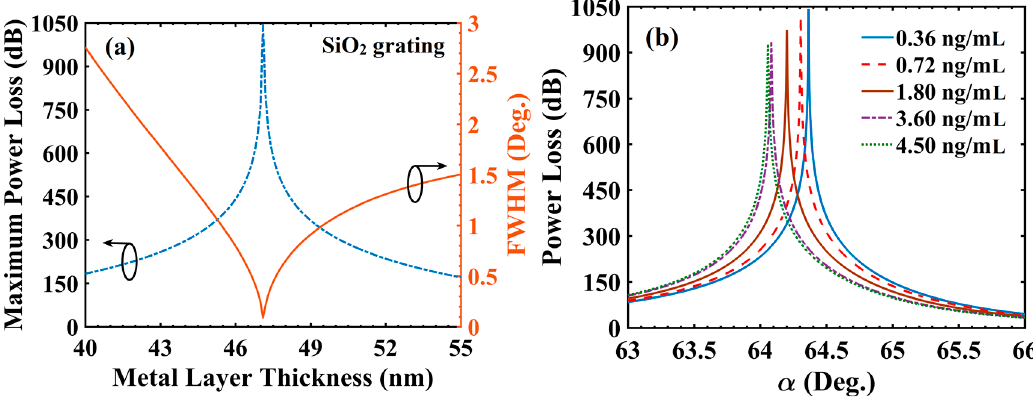
Figure 2. ( a ) Variation of power loss and full width at half maximum (FWHM) with metal layer thickness and ( b ) power loss variation with incident angle for different concentration of cortisol in solution (cortisol-conjugated BSA); d 1 / d = 0.5 (SiO 2 gratings), t Ag = 47.10 nm and λ = 830 nm.